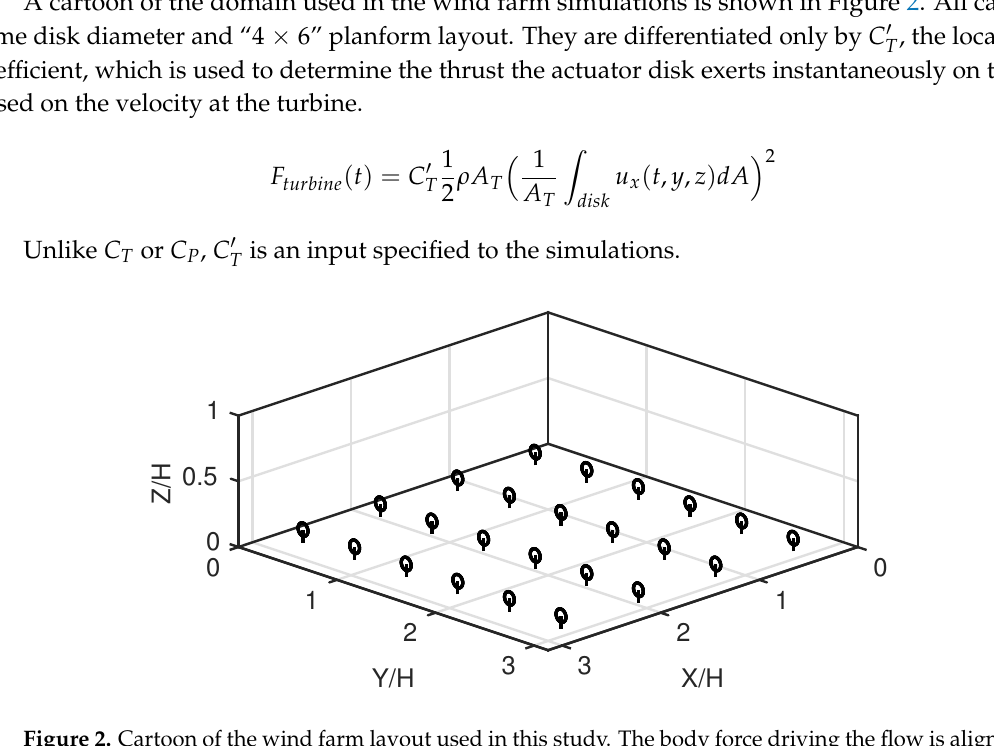
Figure 2. Cartoon of the wind farm layout used in this study. The body force driving the flow is aligned with the positive X-direction. Spatial axes are normalized by the domain height, H